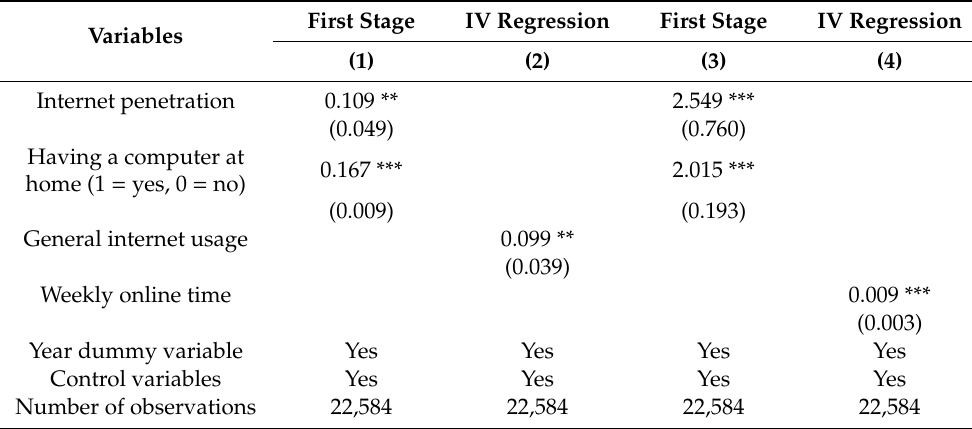
Table 7. Results of instrumental variable (IV)